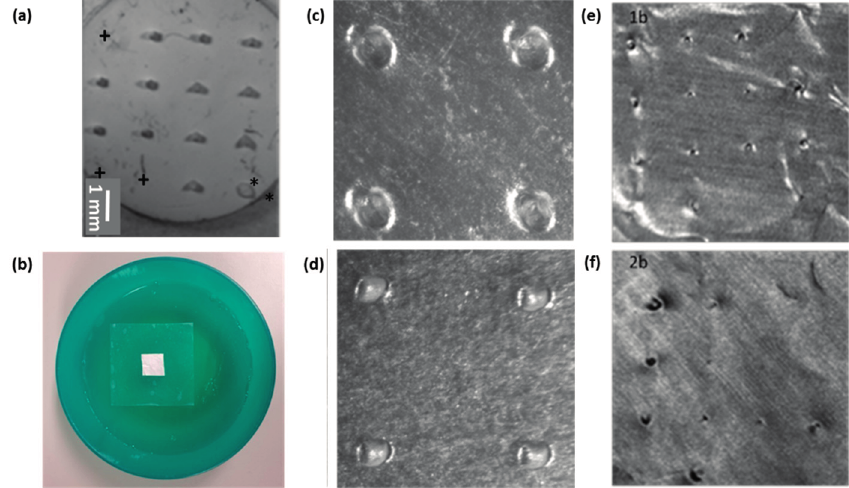
Figure 9. Penetration study with a SN-4×4-D300 npMNA on ballistic gel as a skin model. ( a ) Overview image of the used npMNA, * shows a defect instead of a MN, + indicates missing MNs prior to penetration into the skin model; ( b ) Ballistic gel with the aluminum foil and the parafilm atop; ( c ) Imprints into parafilm with the applicator; ( d ) Imprints into parafilm without the use of the applicator; ( e ) overview of corresponding puncture holes showing 12 out of 12 holes in the aluminum foil with the applicator; ( f ) corresponding puncture holes showing 4 out of 12 holes in the aluminum foil without the use of the